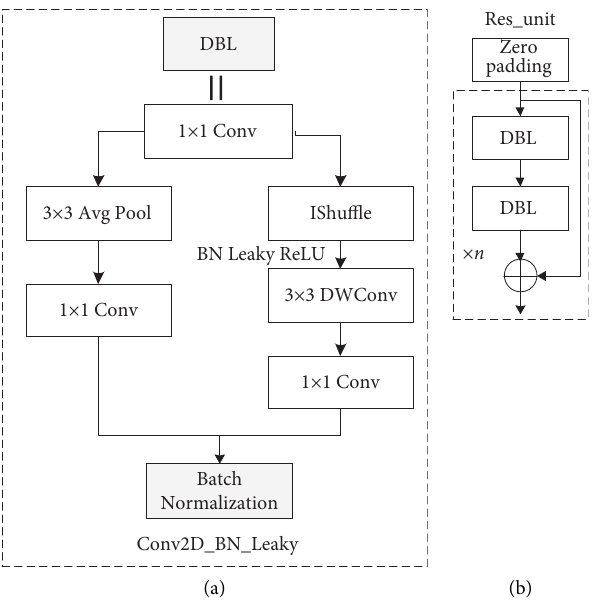
Figure 3: Basic components. (a) Basic components of DBL. (b) Resn